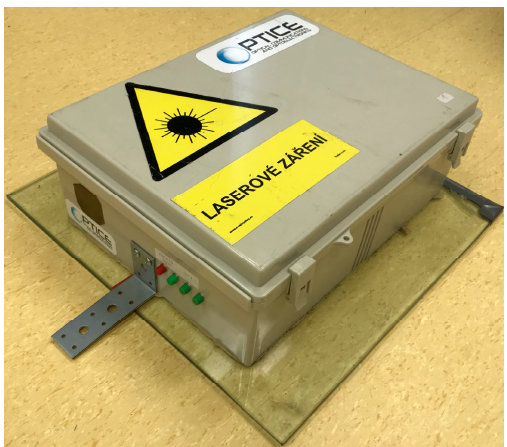
Figure 4. The physical version of the interferometric sensor (photo).